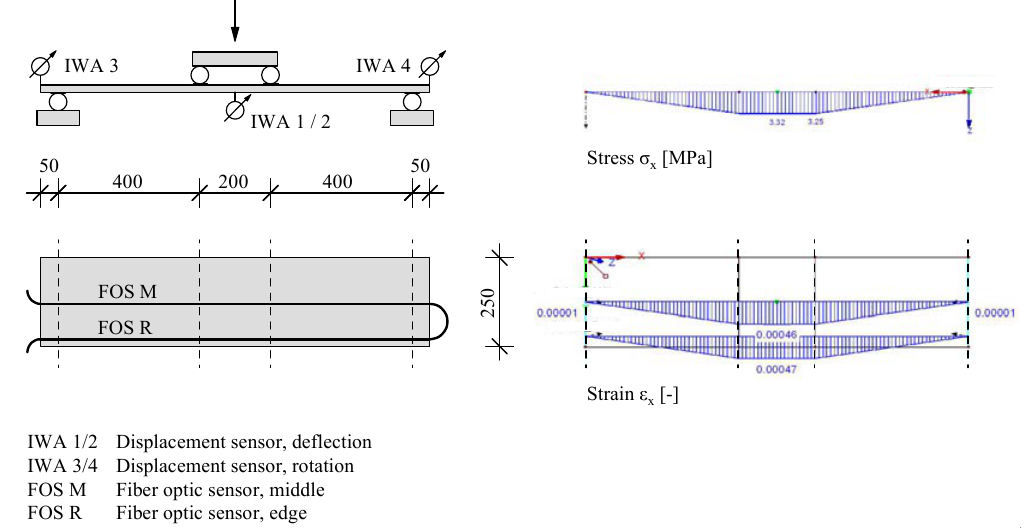
Fig. 4 Four-point bending test on monolithic glass panes. Left: Experimental setup with inductive displacement transducer and fiber optic sensors. Right: Plots of the numerical calculation for stress and strain at glass surface along the longitudinal axis.